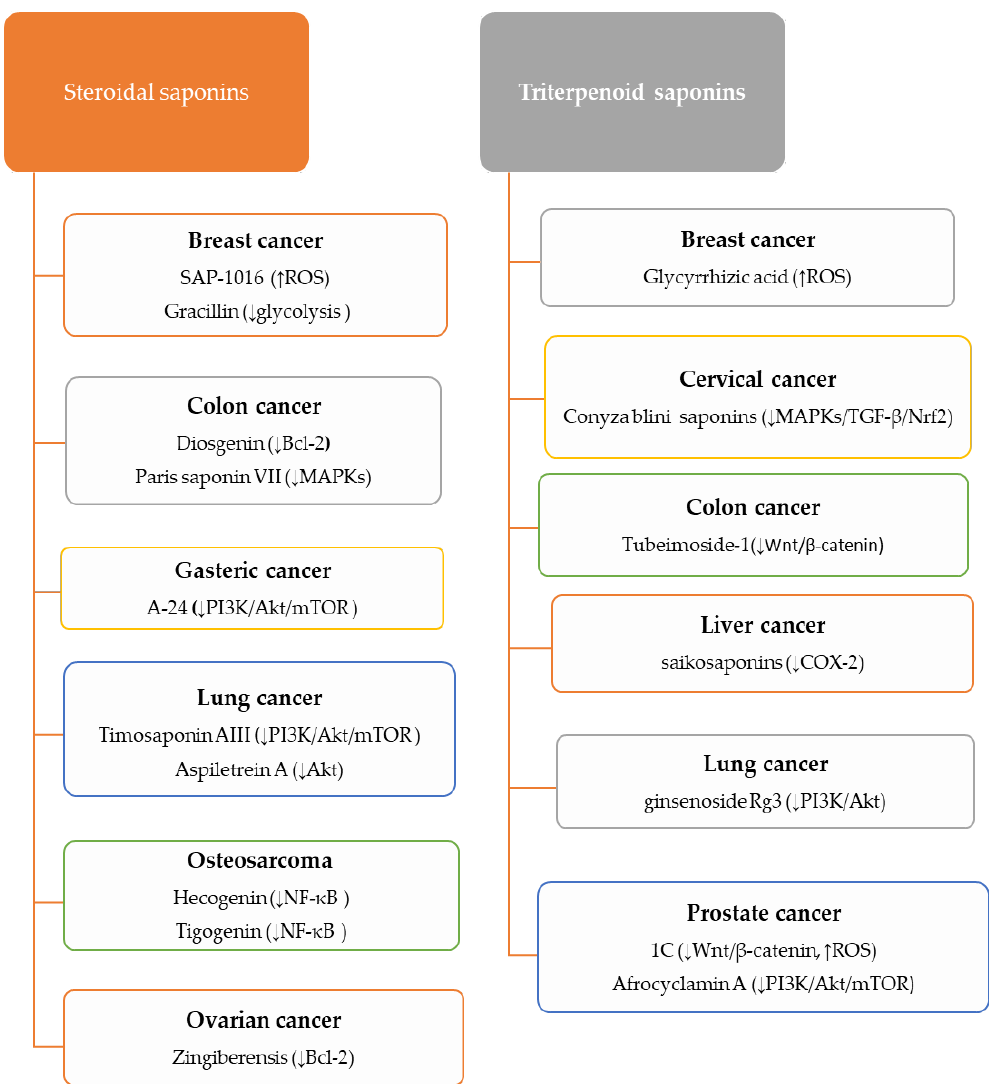
Figure 3. Anti-cancer activities of some steroidal and triterpenoid saponins.